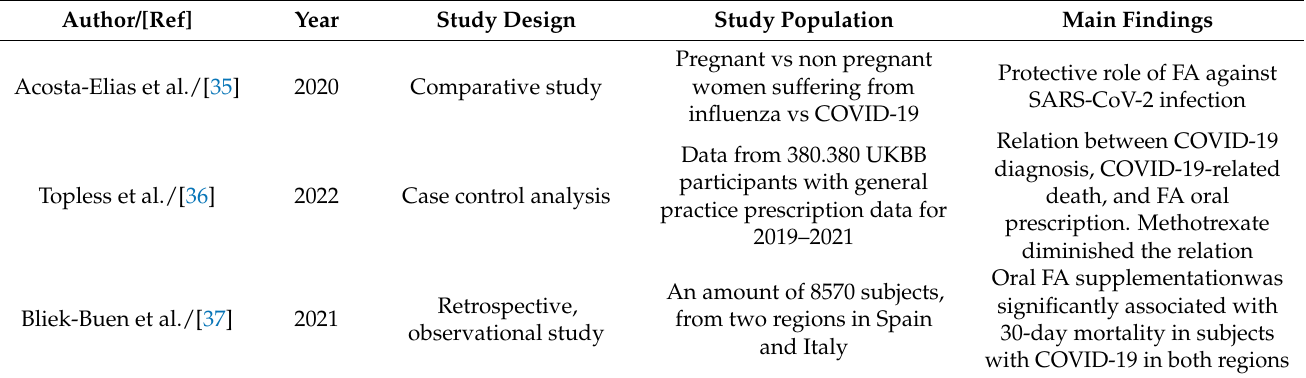
Table 2. Patients’ studies concerning the potential interplay between folic acid and SARS-CoV-2 viral